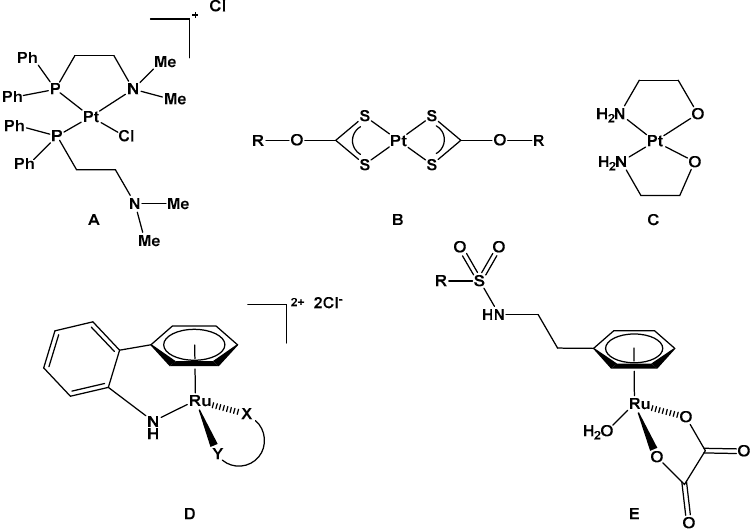
Figure 1. Examples of metallodrugs previously investigated for their pH-dependent reactivity ( A ) cis -[PtCl(Me 2 N(CH 2 ) 2 PPh 2 - N , P )(Me 2 N(CH 2 ) 2 PPh 2 - P )]Cl; ( B ) the general structure of bis( O -alkyldithiocarbonato)platinum(II) complexes; ( C ) ( SP -4-2)-bis(2-aminoethanolato- κ 2 N , O )platinum(II); ( D ) general structure of [Ru{ η 6 : κ 1 -C 6 H 5 (C 6 H 4 )NH 2 }(XY)] 2+ complexes; ( E ) structure of [Ru( η 6 -C 6 H 5 CH 2 CH 2 NHR)(C 2 O 4 )(H 2 O)] (R = Ms, Tf) complexes.